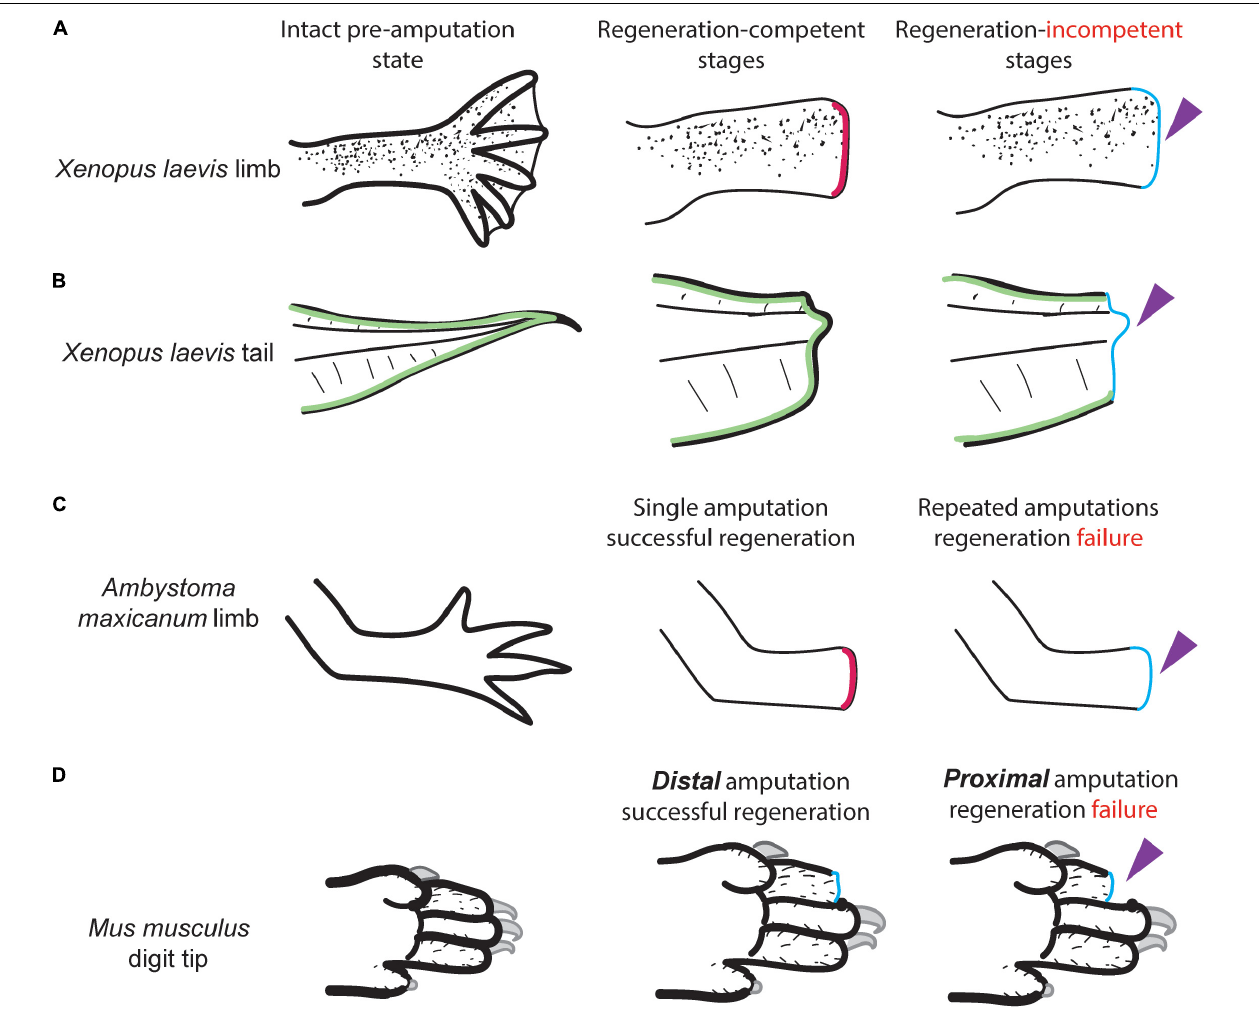
FIGURE 2 | The wound epidermis (WE) formation is not associated with regenerative success in diverse appendage regeneration models. (A, B) Xenopus laevis tadpoles lose their limb and tail regeneration abilities at specific developmental stages. Upon amputations, these animals cannot form an AEC (dark pink) at these stages but can still form the WE (light blue; Beck et al., 2009). (A) X. laevis tadpole limb regeneration ability is associated with the successful specification of AER cells to form the AEC; regeneration-incompetent tadpoles cannot specify AER cells but can still seal the amputation plane, hence they can form the WE (Aztekin et al., 2021). (B) X. laevis tail regeneration depends on the ability to relocalize their regeneration-organizing cells (ROCs; green) to amputation plane to act as the AEC (Aztekin et al., 2019). Regeneration-incompetent tadpoles cannot relocalize their ROCs, but can still seal the amputation plane, hence they can form the